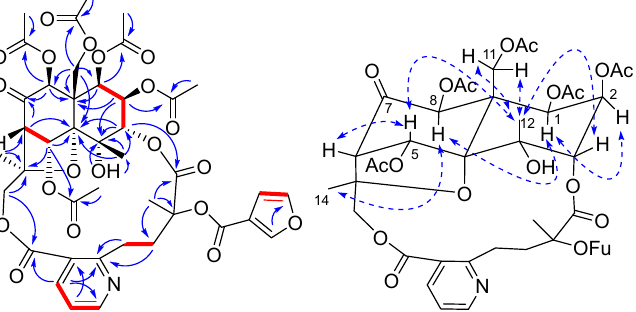
Figure 3. Key 2D NMR correlations of 9 [red lines for 1 H- 1 H COSY, blue arrows for HMBC (from H to C), dashed two-way arrows for ROESY].